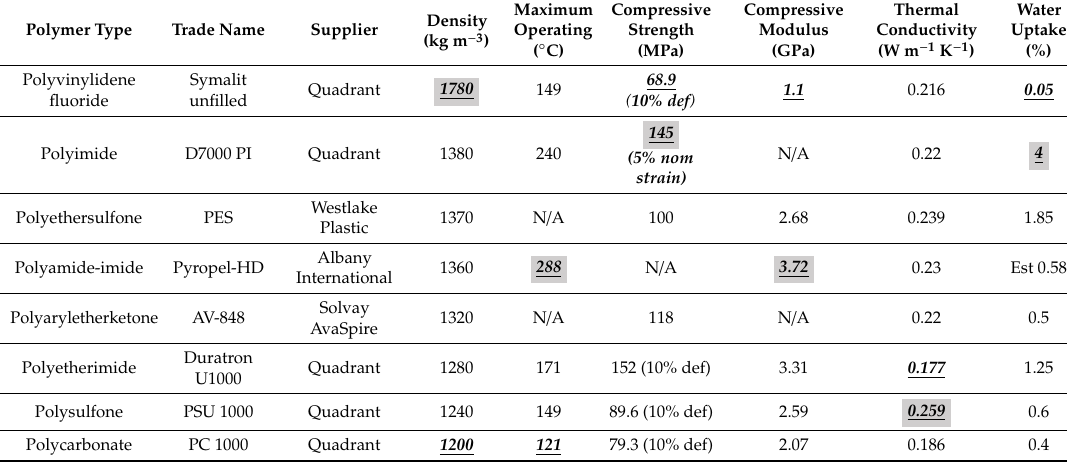
Table 1. High-density polymers considered for the gas manifold of the quasi-adiabatic PEMFC fixture. The highest and lowest material properties values of each type are underlined and the highest is further identified by a shaded gray box. Not available (N /